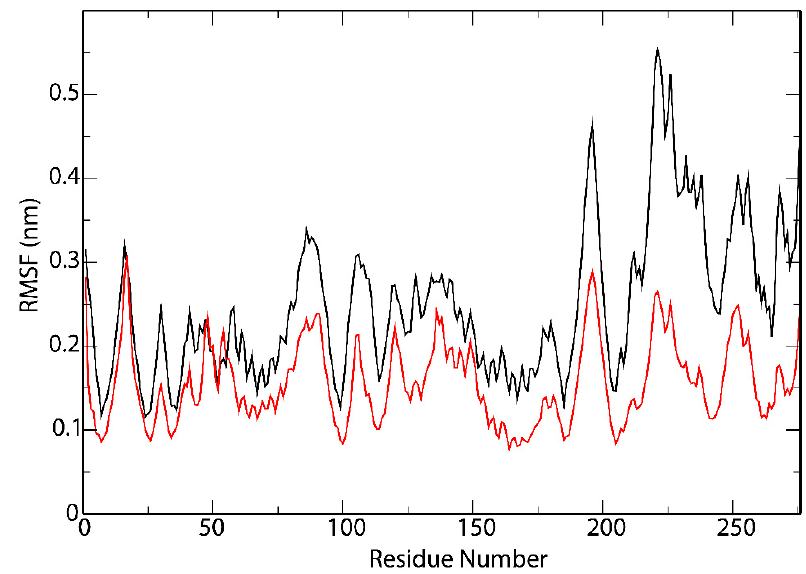
Figure 6. Root-mean square fluctuations (RMSF) values of the backbone through the Molecular Figure 6. Root ‐ mean square fluctuations ( RMSF) values of the backbone through the Molecular dy ‐ dynamics (MD) simulation of the peptide/protein complex between YQPYRVVVL and HLA-B*08:01 namics (MD) simulation of the peptide/protein complex between YQPYRVVVL and HLA ‐ B*08:01 (black), and the peptide-free protein HLA-B*08:01 (black), and the peptide ‐ free protein HLA ‐ B*08:01 (red).